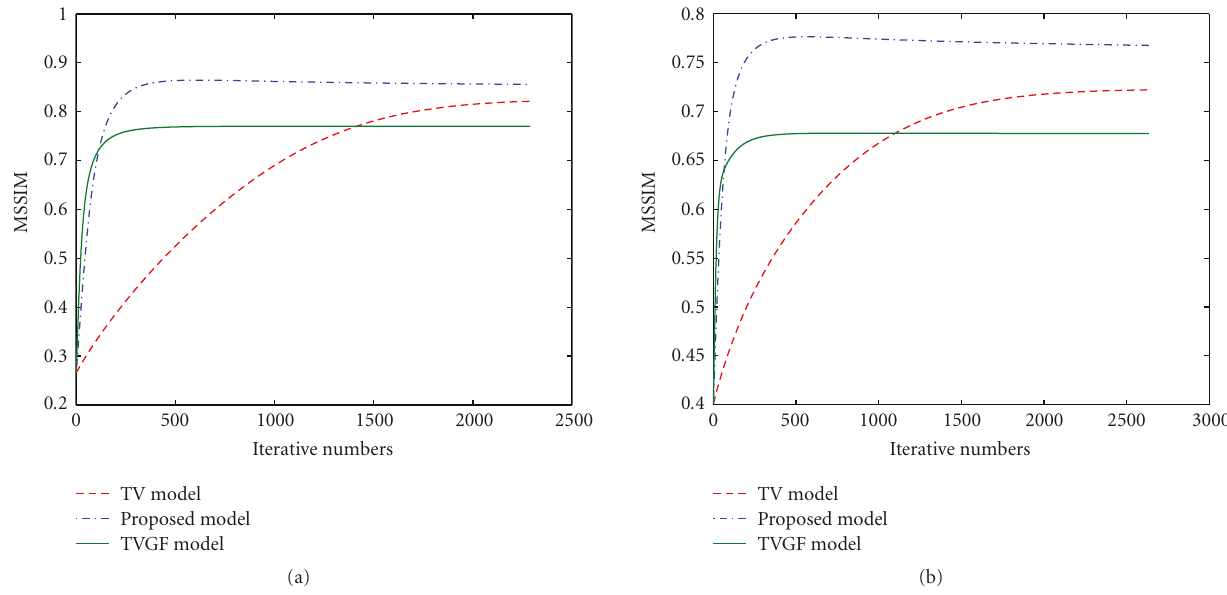
Figure 17: Comparison of the MSSIM results of the di ff erent images which is corrupted by some Gaussian noise of standard deviation 25: (a) “Lena”; (b) “Barbara”.